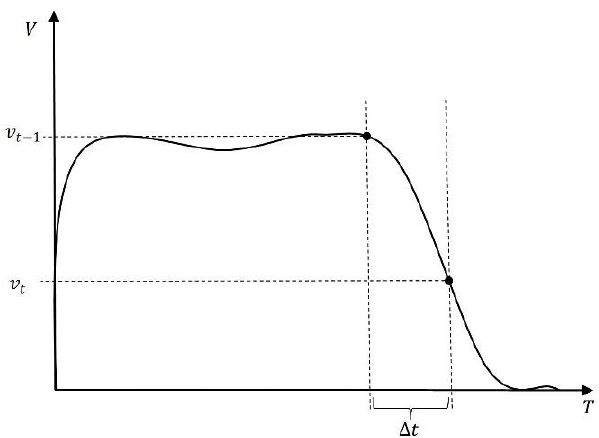
Figure 6. The movement speed of the interactive object.